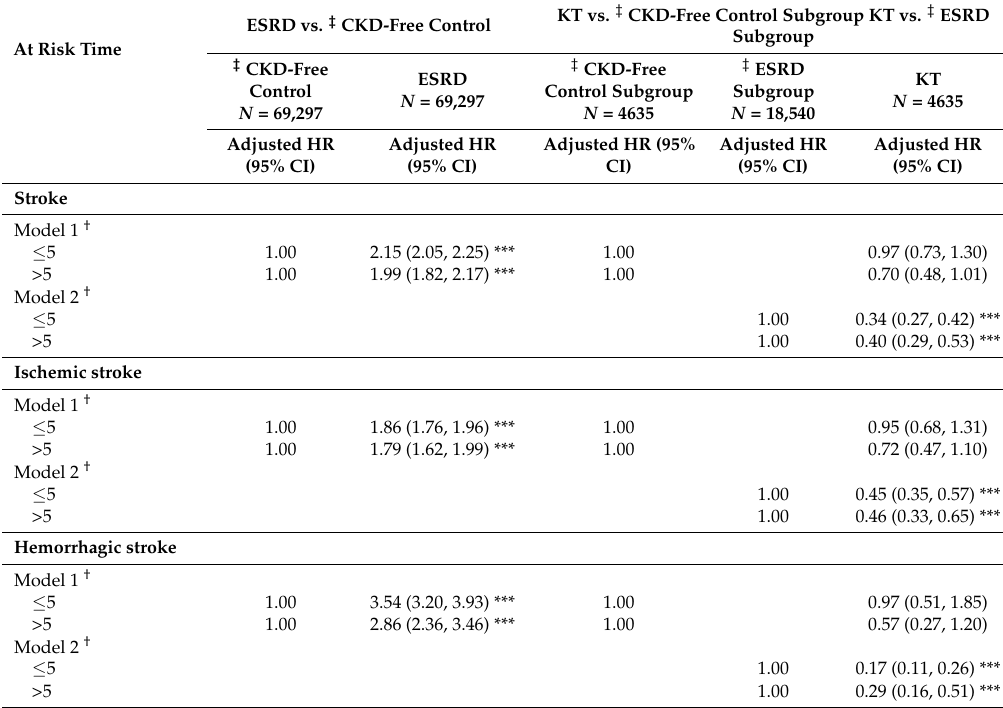
Table 4. Adjusted hazard ratios for stroke in the ESRD, KT, and control groups stratified by at-risk time. KT vs. ‡ CKD-Free Control Subgroup KT vs. ‡ ESRD ESRD vs. ‡ CKD-Free Control Subgroup At Risk Time